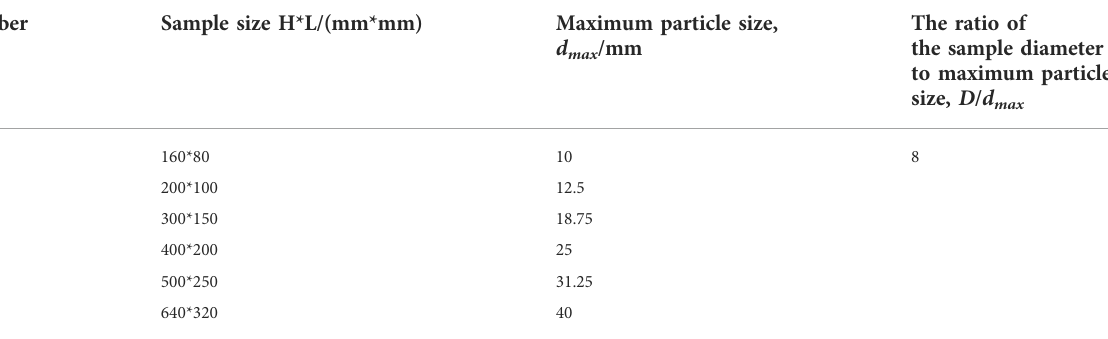
TABLE 2 Numerical simulation test scheme.